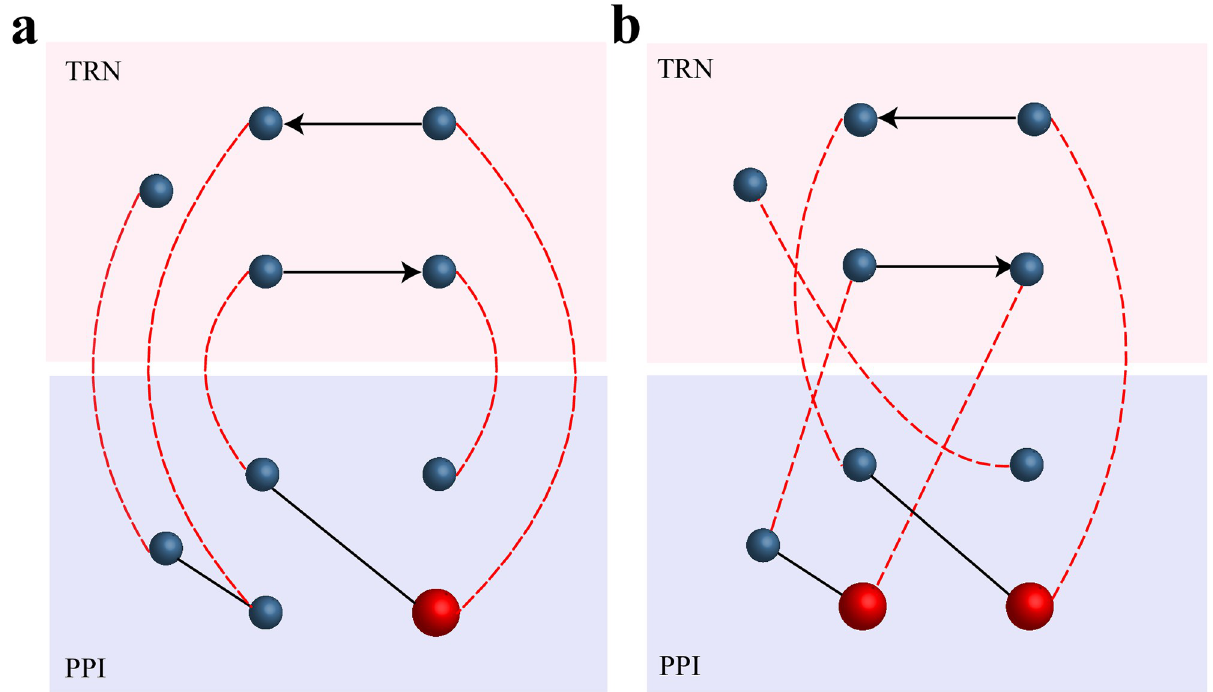
Fig 1. Schematic diagram of TRN-PPI multiplex networks with different interlayer couplings. The nodes in the two layers represent the genes and proteins. The red nodes are the minimal driver nodes that are imposed on the external inputs. The black directed lines represent the interactions between the transcription factors and their target genes in the TRN layer, and the black undirected lines represent the interactions between the proteins in the PPI layer. The red dashed lines represent the one-to-one interactions between the genes and their corresponding proteins. The interlayer couplings are different in (a) and (b) ; thus, the minimal driver node sets